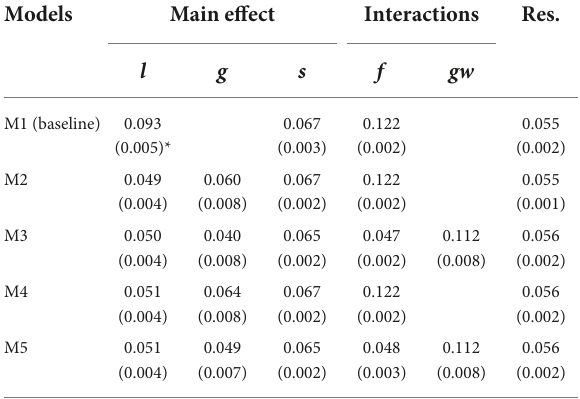
TABLE 4 Posterior mean of variance components for grain yield (kg grain/8.25 m 2 ).